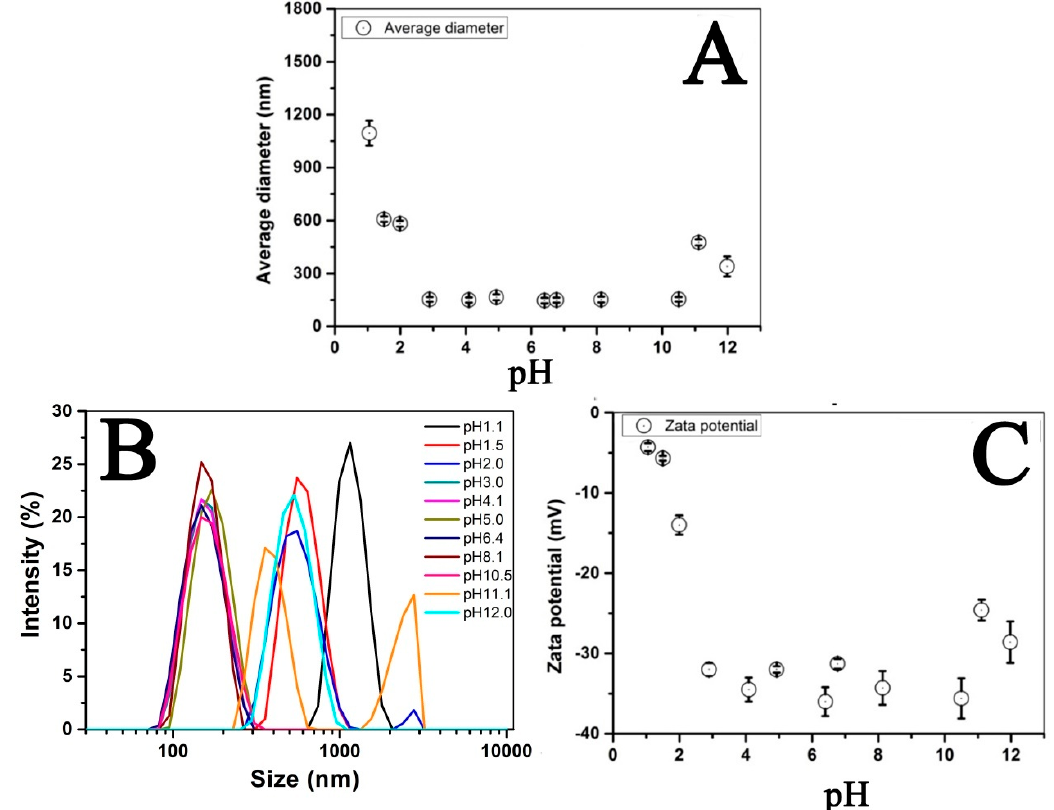
Figure 6. Effects of pH on ( A ) average size of Fe 3 O 4 @LNPs, ( B ) size distribution of Fe 3 O 4 @LNPs, and ( C ) zeta potential value of Fe 3 O 4 @LNPs.